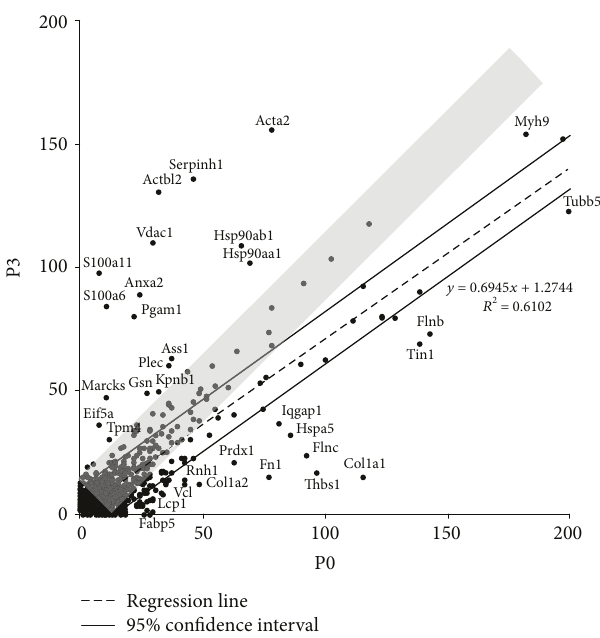
Figure 4: A scatter plot of the quantitative value (normalized emPAI) per housekeeping gene. A scatter plot showing correlation ( R 2 = 0 6102 ; gray band indicates “ R 2 = 1 ” ) between the quantitative value of the mouse primary cultured cells (P0) and cells passaged 3 times (P3) ( n = 1139 ). The dotted line is the regression line. The two lines indicate the 95% con fi dence interval. Each dot shows the abbreviated name of the